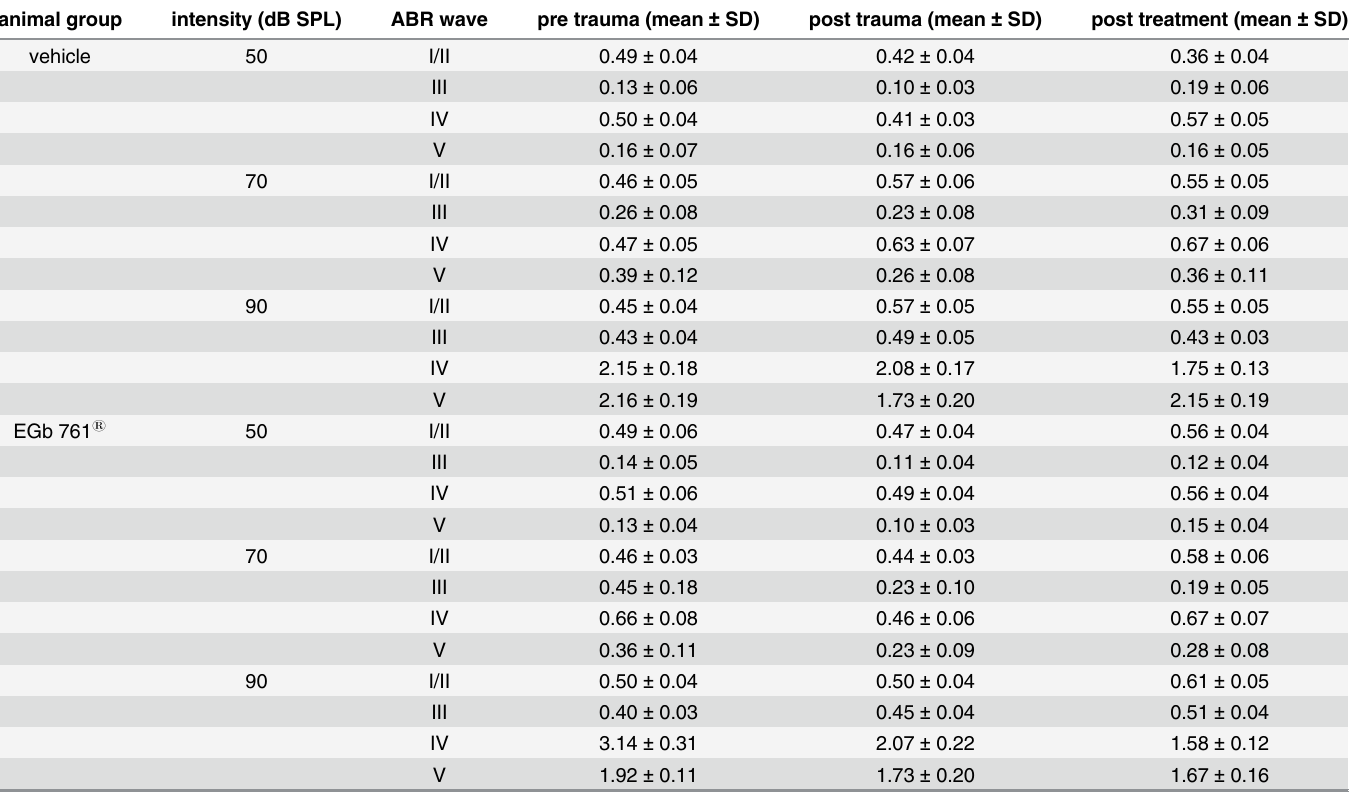
Table 1. Mean response amplitudes of ABR waves (mV) at an amplification of 10.000:. animal group intensity (dB